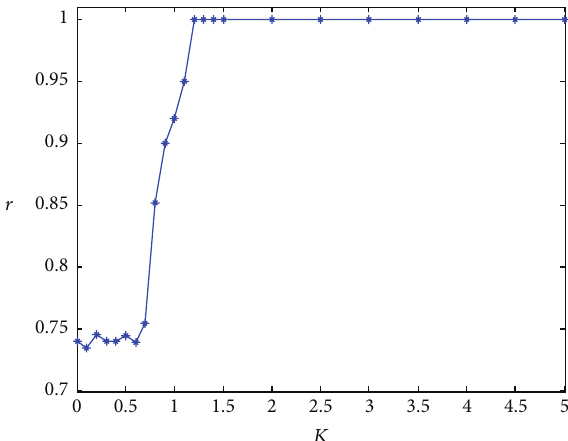
Figure 9: When group is local-coupling, the threshold 𝐾 𝑐 is about 1.2 for consensus synchronization in vent collective